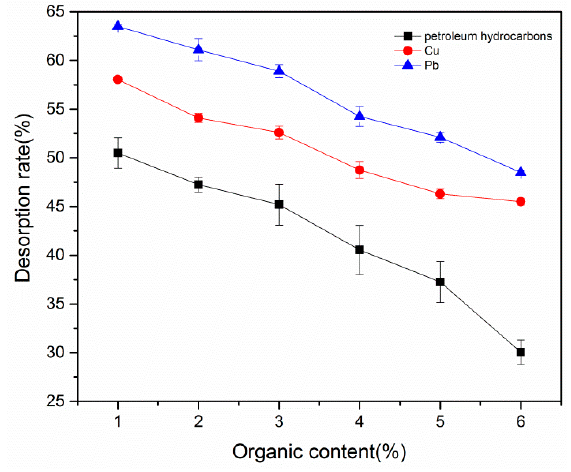
Figure 7. Effect of organic matter concentration on desorption.